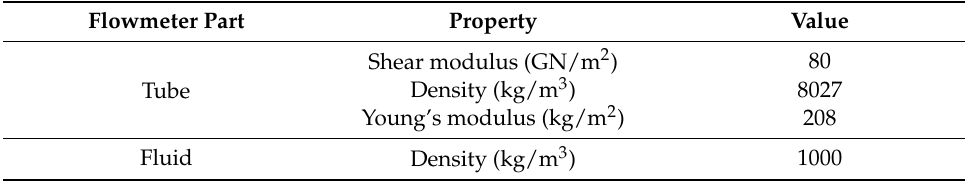
Figure 1. The Coriolis flowmeter dimensions [7,24]. Table 1. Tube and fluid properties